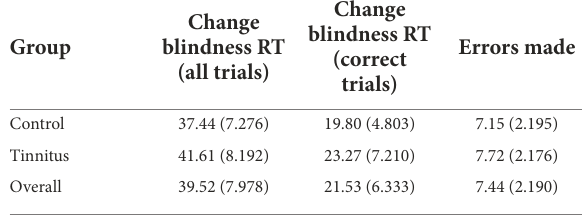
TABLE 3 Change blindness task descriptives, considering RT, and errors made.